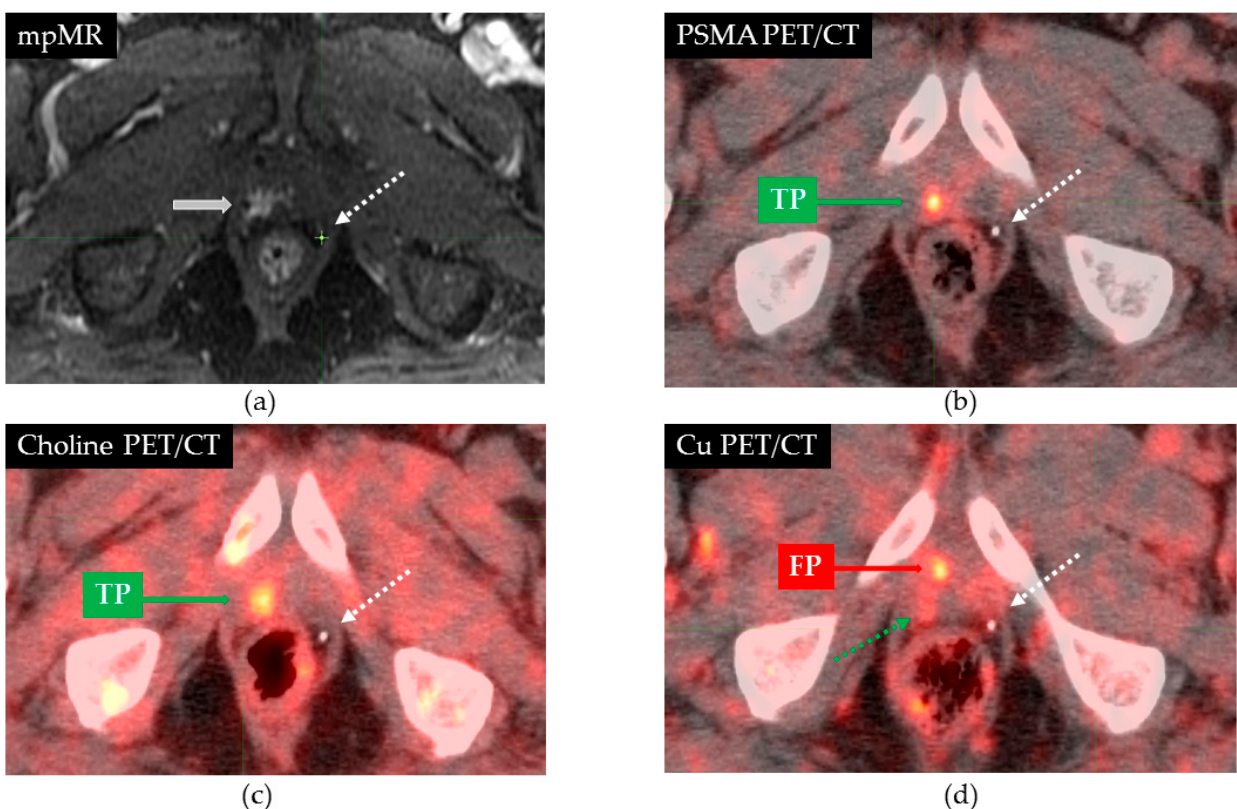
Figure 1. Axial slices showing the position of the nodule on the various imaging modalities: mpMR ( a ), PSMA/PET ( b ), CH/PET ( c ), and CU/PET ( d ). On multiparametric MR, the nodule is indicated by the thick white arrow. A focal lesion is shown on all PET/CT scans, while the dashed white arrow indicates the position of a calcification. The distances between the centroid on mpMR and PSMA PET/CT, Cu PET/CT, and choline PET/CT were 0.43, 1.21, and 0.47 cm, respectively. Therefore, lesions seen on both PSMA and choline PET/CT were considered true positives (TP), while the one on CU PET/CT was a false positive. Interestingly, on Cu PET/CT, a blurred mild uptake was detected in the area that would correspond to the TP lesion on mpMR (green dashed line).